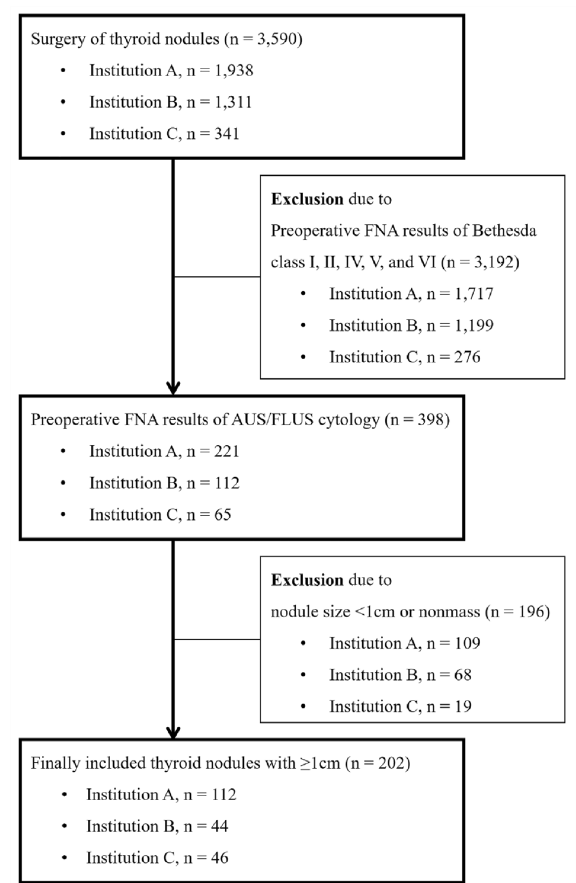
Figure 2. Diagram of the study group which included patients from 3 different hospitals. FNA fine-needle aspiration, AUS atypia of undetermined significance, FLUS follicular lesion of undetermined